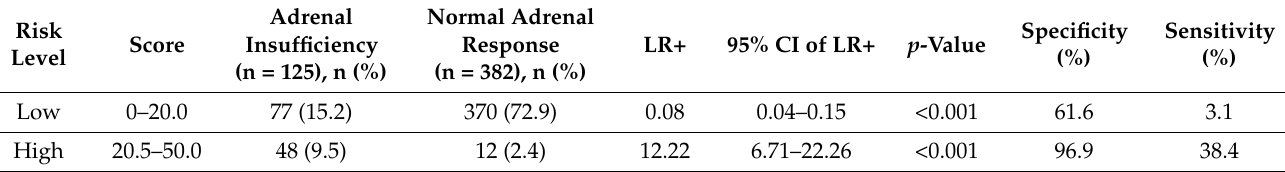
Table 4. Distribution of risk of adrenal insufficiency, LR+ and 95% CI of